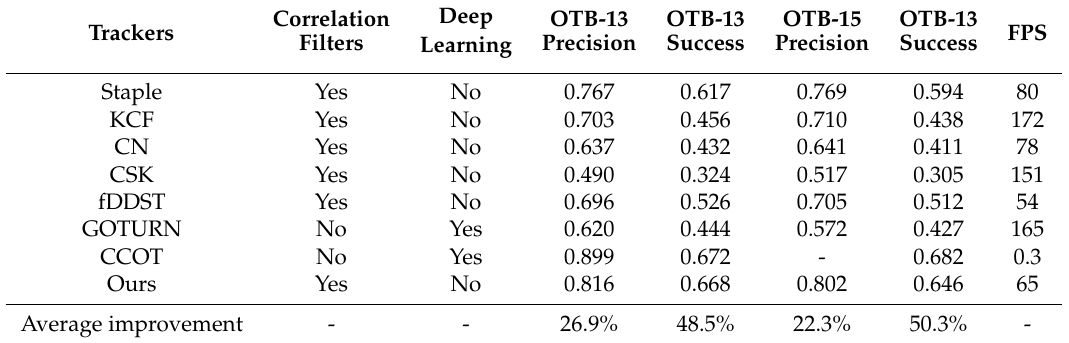
Table 3. The comparison results with the other 7 state-of-the-art trackers on OTB-13 and OTB-15.